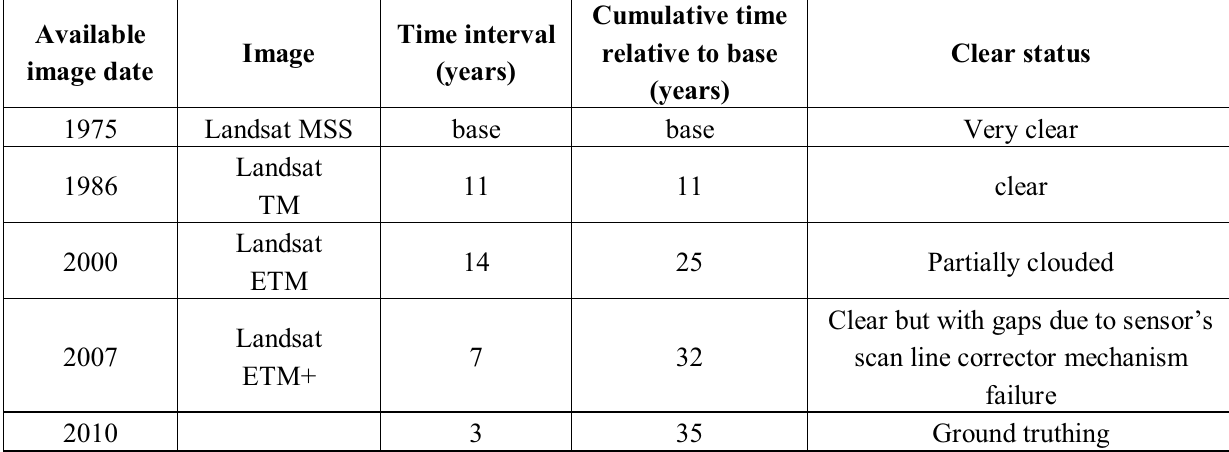
Table 1. Characteristics of satellite images used in the Cameroon spatial change